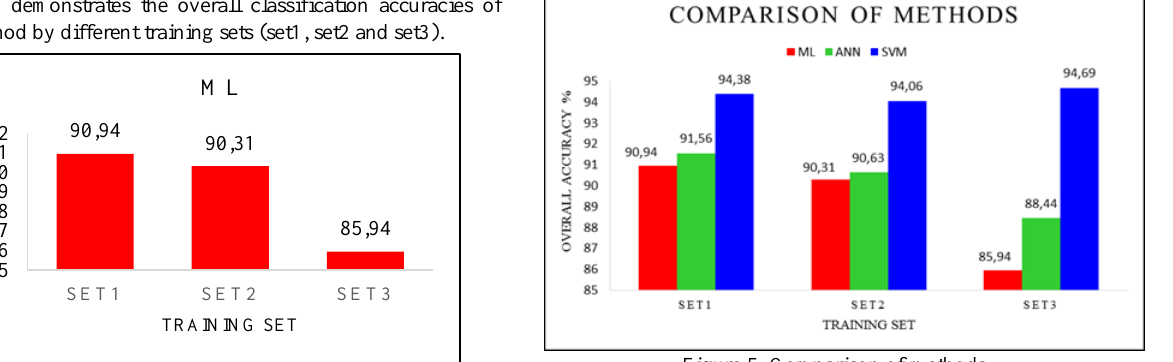
Figure 5. Comparison of